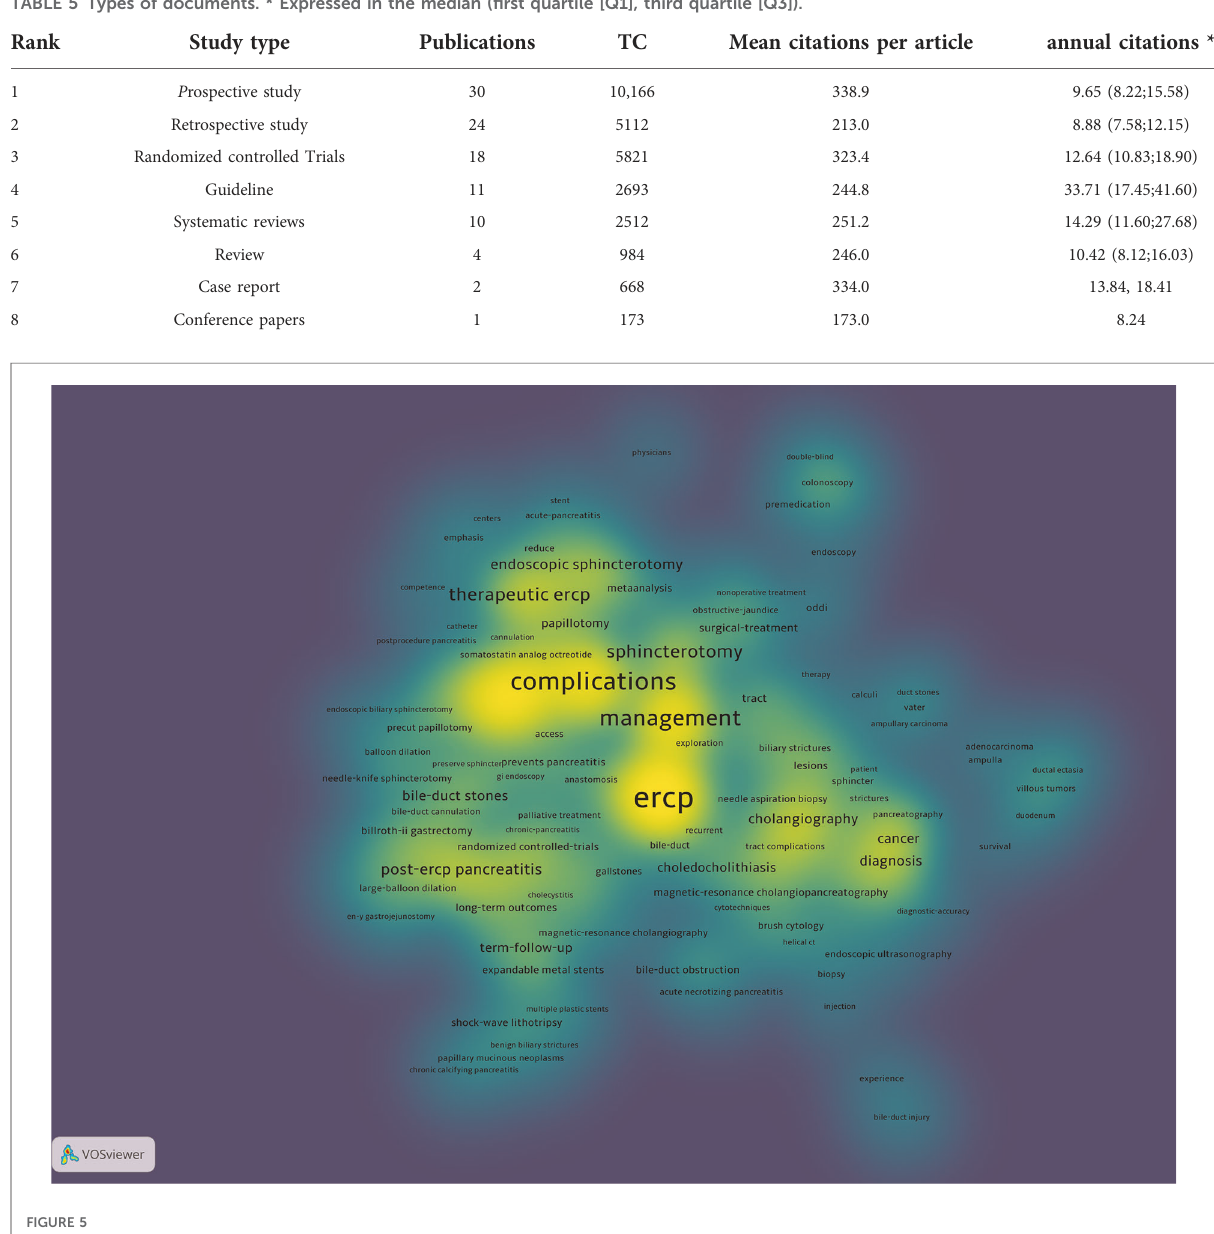
FIGURE 5 Heat map of the 100 most-cited articles in keywords. The darker the color, the more times the keyword